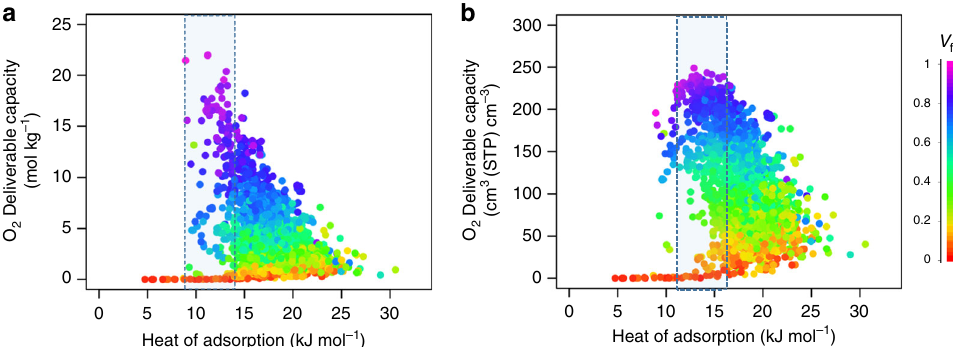
Fig. 1 Structure – property relationships for oxygen storage in MOFs. Oxygen a gravimetric and b volumetric deliverable capacity (at 140 bar storage and 5 bar release pressures) vs. heat of adsorption for 2,932 MOFs. Each point in the graph represents a different structure. The data points are color coded by void fraction ( V f ). See http://aam.ceb.cam.ac.uk/mof-explorer for interactive structure – property